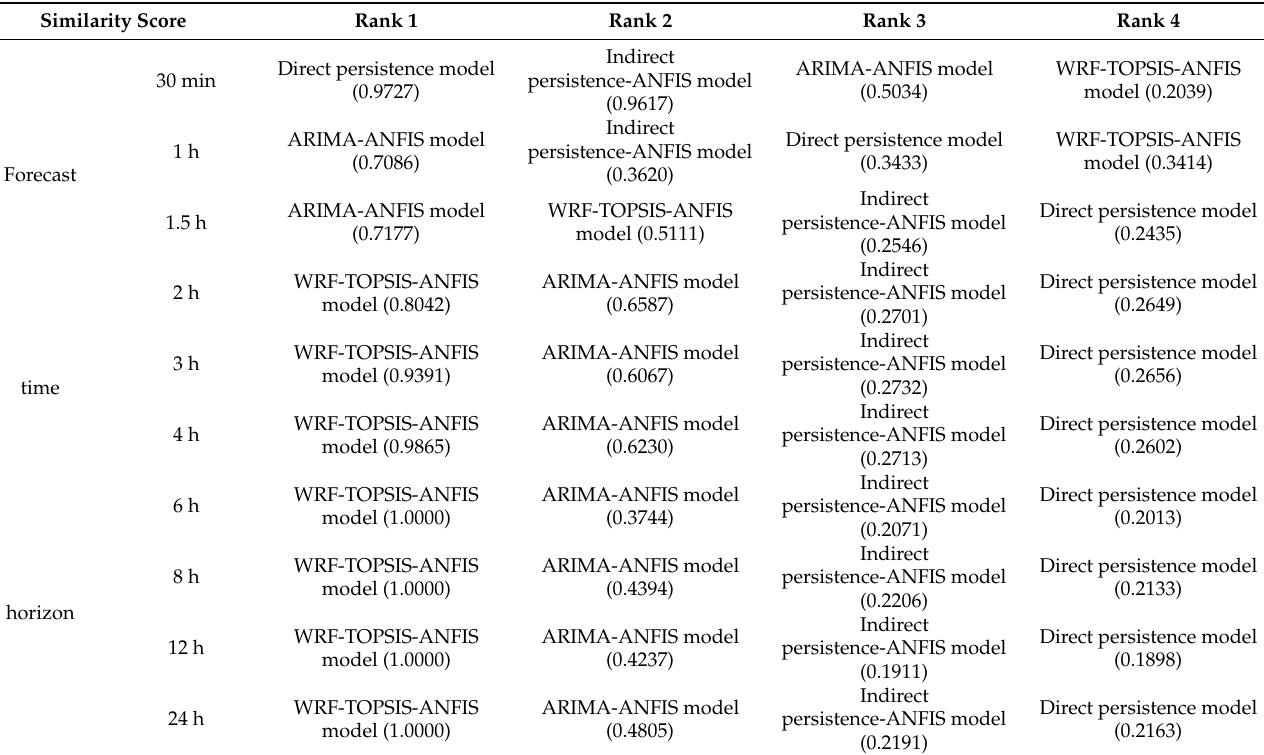
Table 19. Model rankings for each forecast time horizon according to the similarity